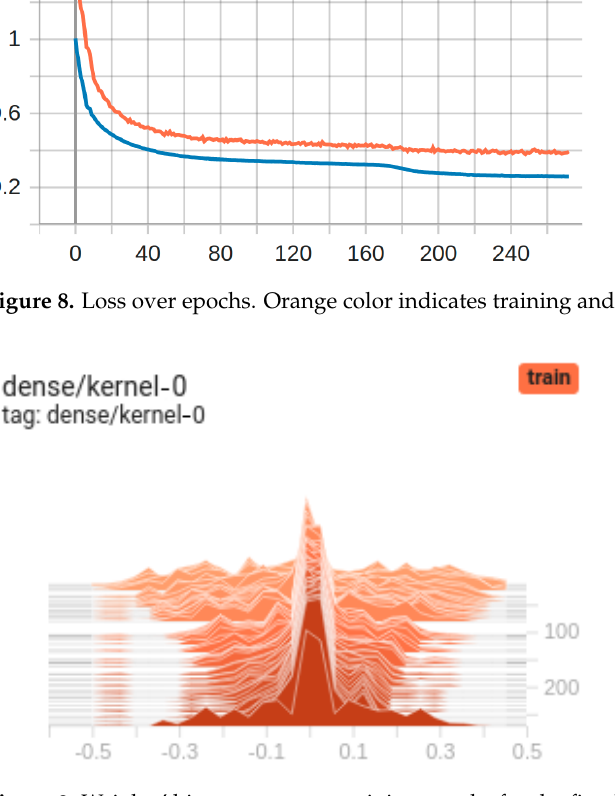
Figure 9. Weights’ histograms over training epochs for the first